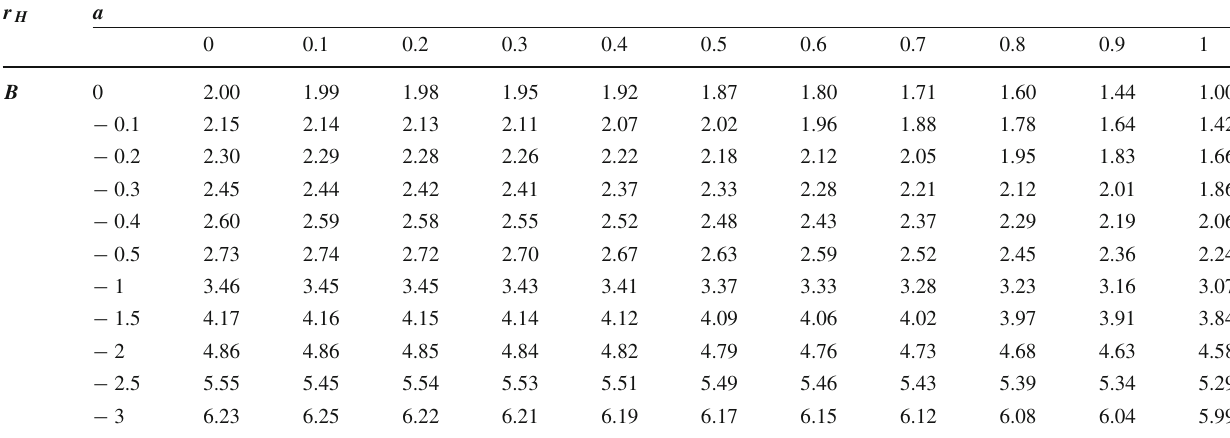
Table 1 Numerical values of r H for varying B and